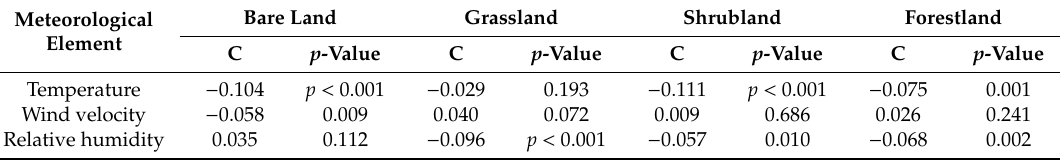
Table 10. Results of the Spearman correlation coe ffi cient and significance level between volumetric soil moisture content variations, per hour, and temperature, wind velocity, and relative humidity in a period without